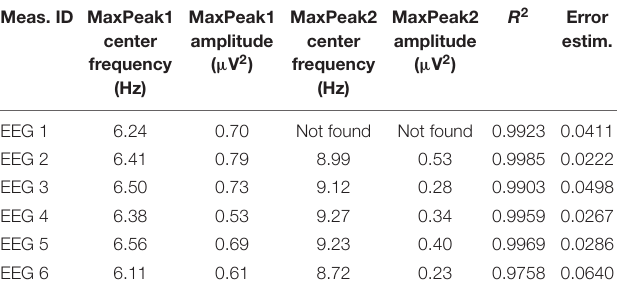
TABLE 3 | The detailed information about the MaxPeak1 and MaxPeak2.